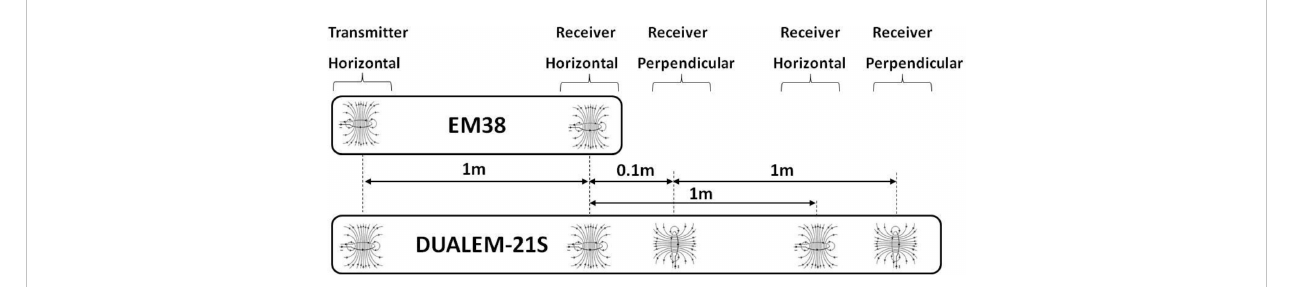
FIGURE 2 EMI sensors at normal position: EM-38 and DUALEM-21S, modi fi ed from Simpson et al. (22).